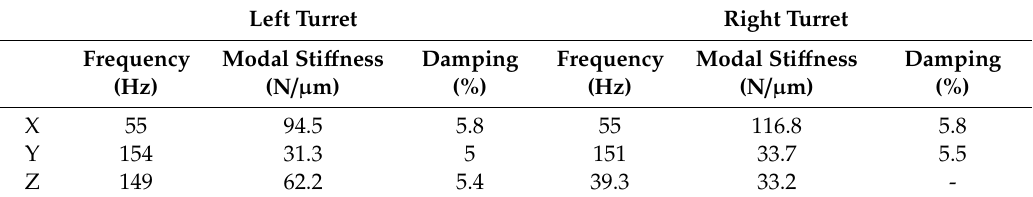
Table 2. Dynamic properties of the main modes.